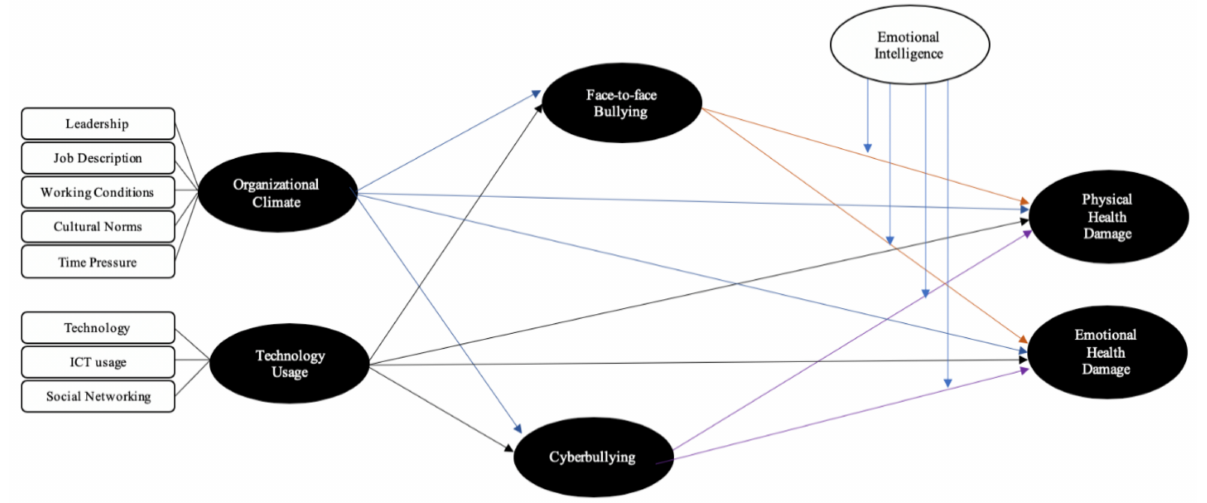
Figure 1. Conceptual framework